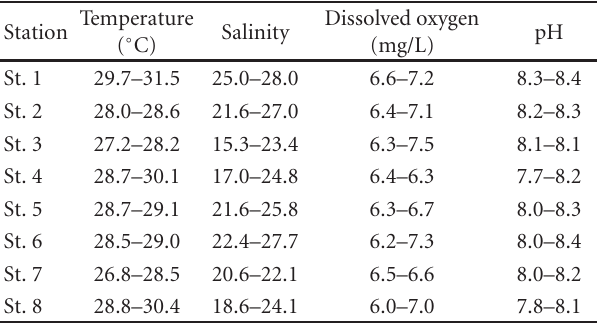
Table 2: Physicochemical parameters for each locality in Bahia Malaga estuary from May 2006 to May 2007.